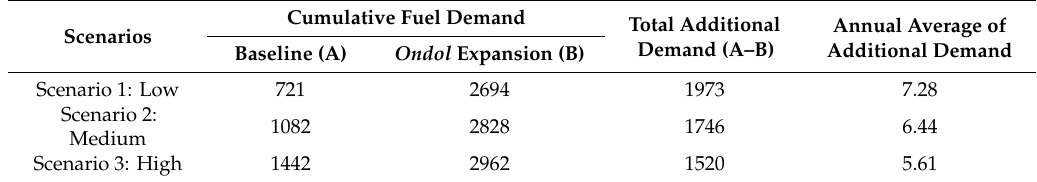
Table 4. Additional fuelwood demand by scenario (unit: million m 3 ).